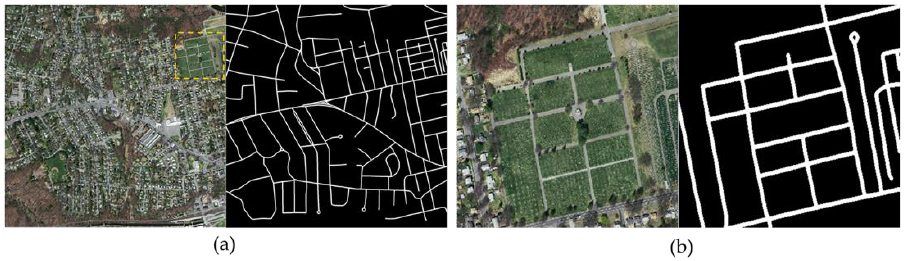
Figure 1. Example of images and labels from the Massachusetts Roads Dataset. ( a ) includes the original image and label, and the label has two classes which are road (white) and background (black). ( b ) is the local magnification of ( a ).